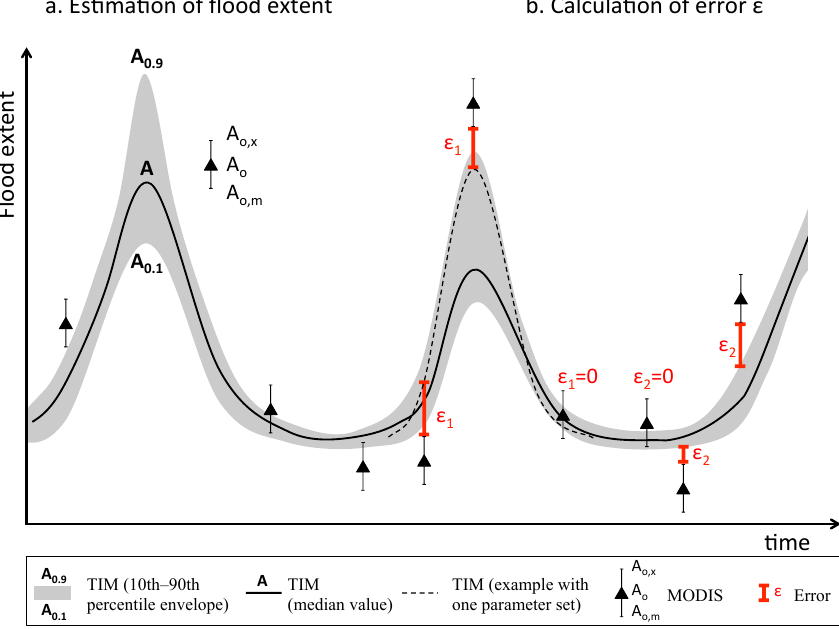
Fig. 5. (a) Simplified scheme depicting the flood extents from TIM and MODIS. (b) Definition of the error (cid:15) 1 and (cid:15) 2